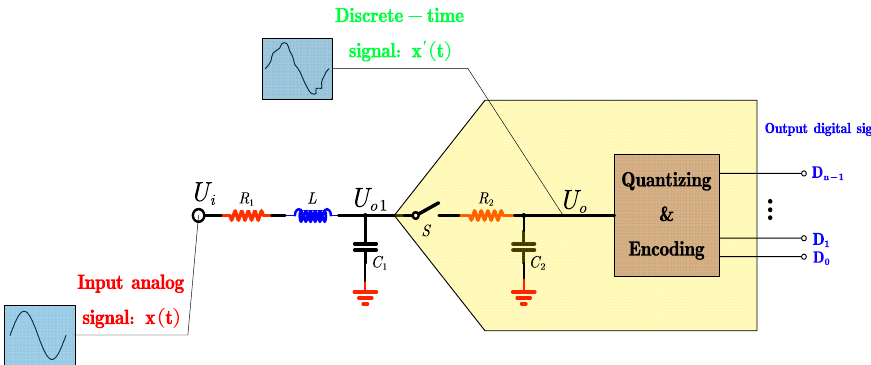
Figure 4. Equivalent model of a single sub-channel in a TIADC system under an ideal state.